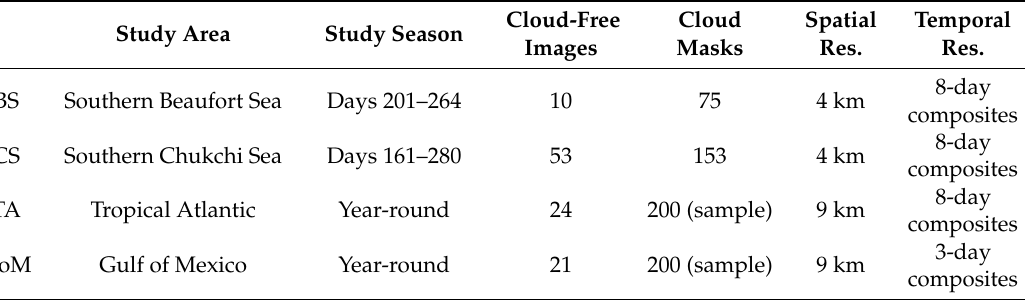
Table 1. Overview of the study